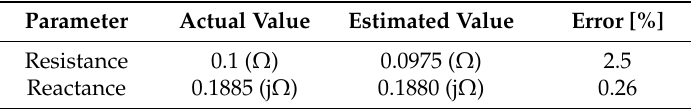
Table 1. Line impedance estimation results.